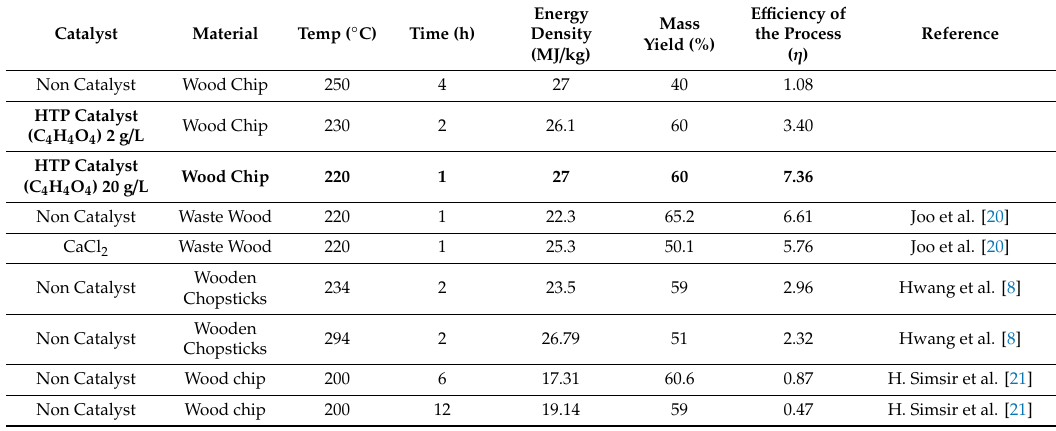
Table 4. Comparison of hydrothermal process results for wood with catalyst and